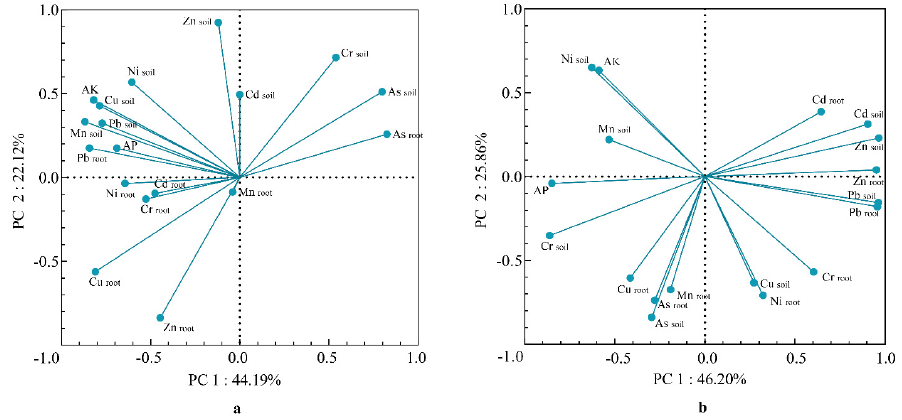
Figure 4. The Pearson correlation coefficients between plant root HM concentrations and soil HM, AP, and AK concentrations in the Jiulong iron tailing area ( a ) and Yangtiangang lead-zinc tailing area ( b ). The ‘s’ and ‘r’ in the subscript denote soil and root, respectively. Bold numbers indicate the statistically significant ones, and correlation is significant at the 0.05 level (2 − tailed).